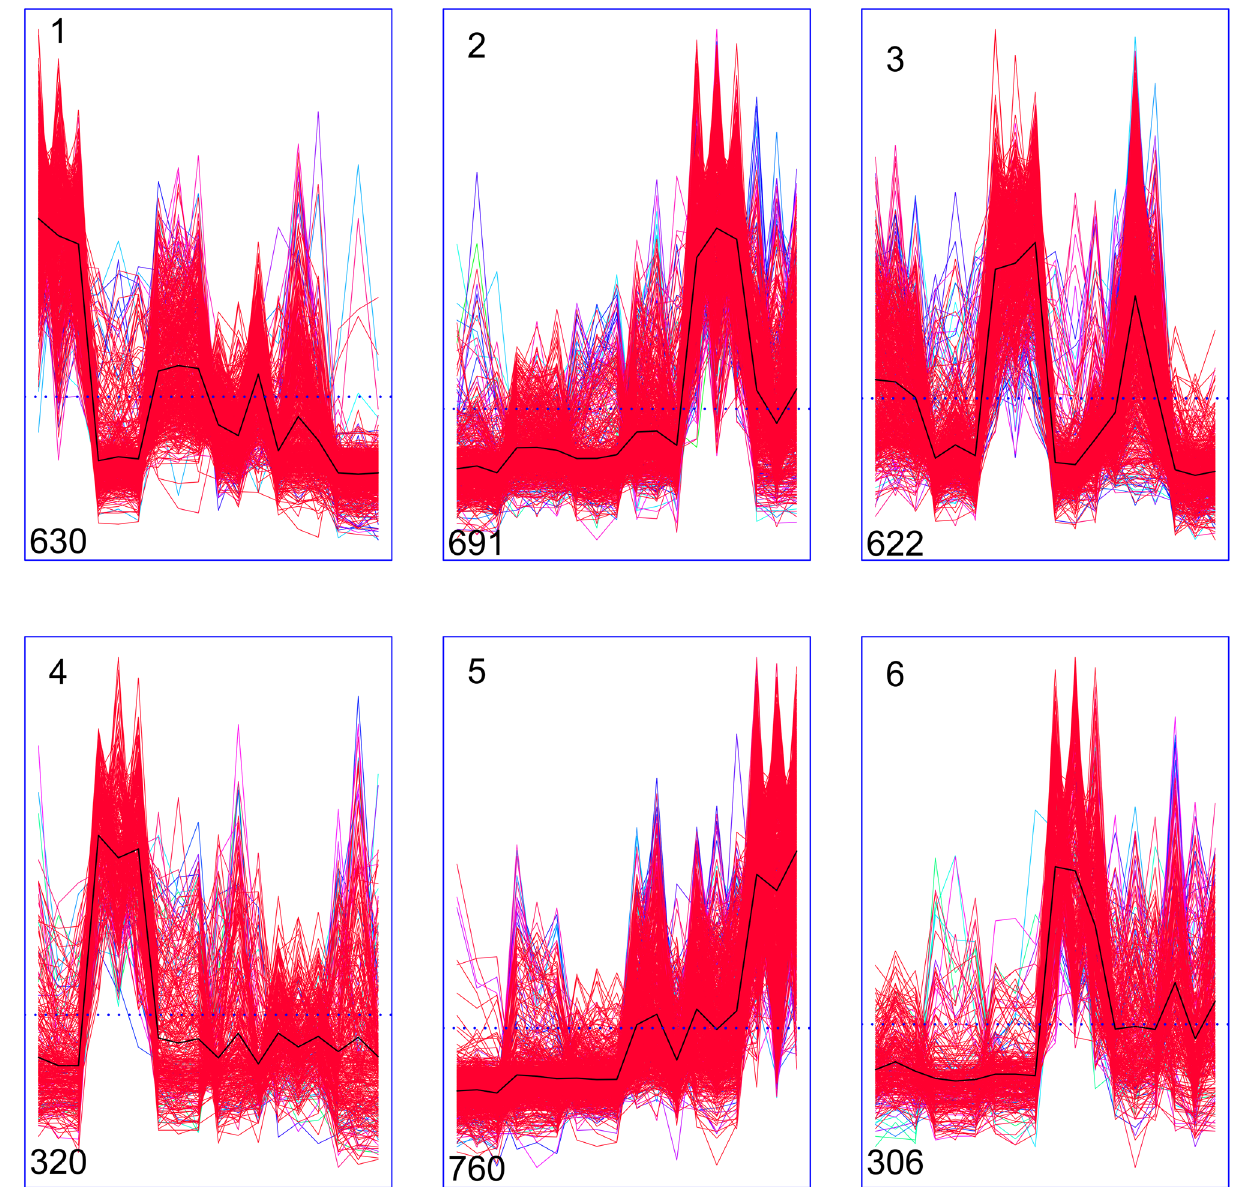
Figure 4. Line graph for the cluster expression of 3329 DEGs. CK: Control group; SS: 300 mM Na 2 SO 4 . The X-axis shows the different treatments (from left to right: CK_L1, CK_L2, CK_L3, CK_R1, CK_R2, CK_R3, panel is cluster number. The number on the bottom left side of cluster panel is genes number of each cluster. Black lines represent the average value of the relative expression level of all genes included in the